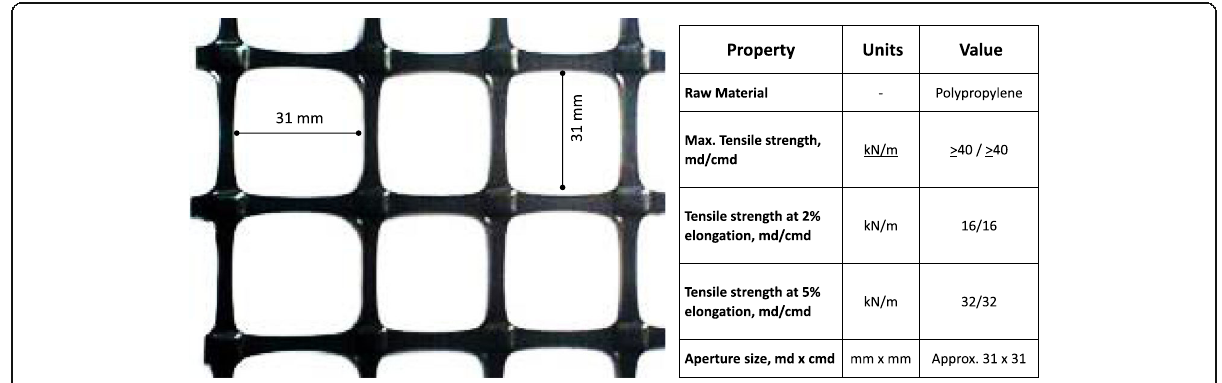
Fig. 6 Grid used in the field construction and properties of